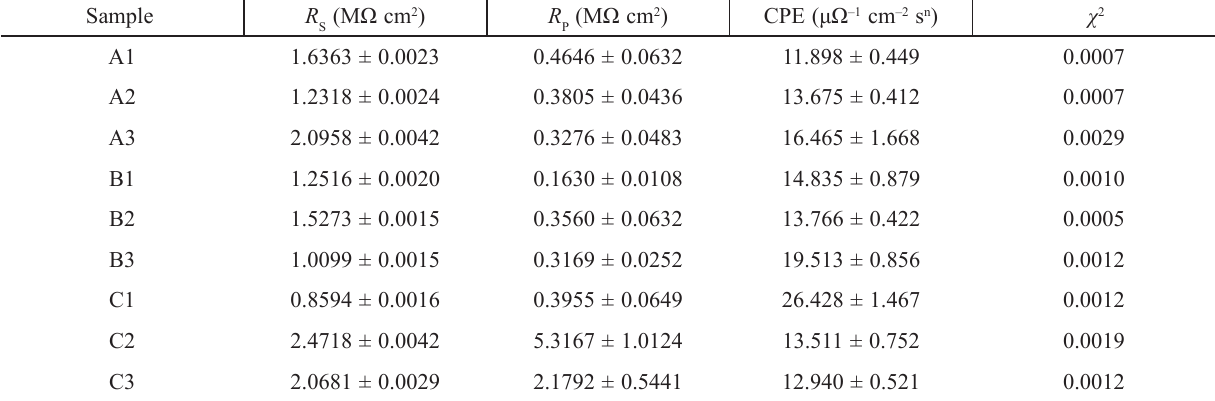
Table 2 – Estimated impedance parameters Sample